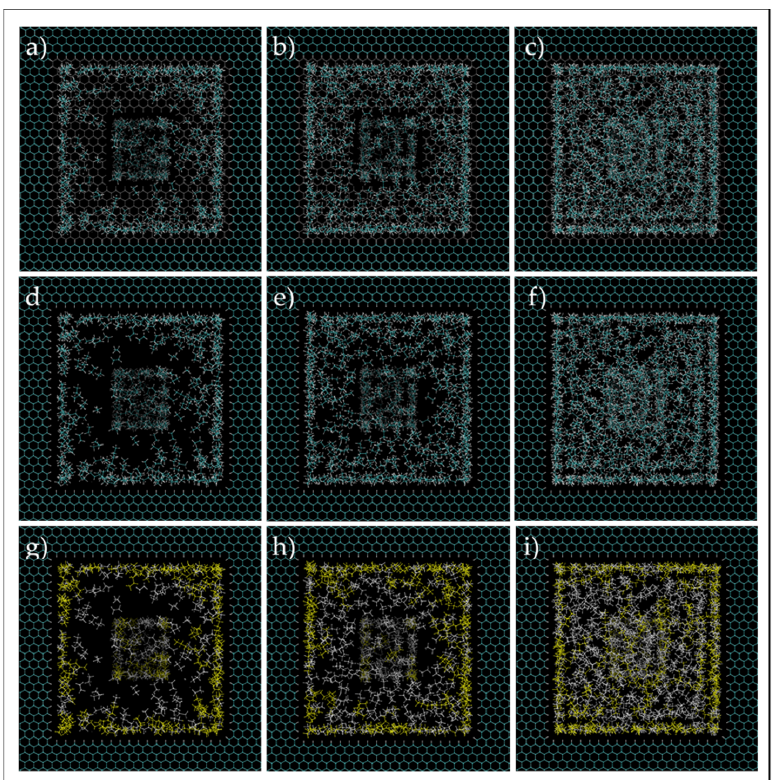
Figure 17. Ethane–heptane mixture simulation in two connected nanopores at C1 ( a , d , g ), C2 ( b , e , h ), C3 ( c , f , i ). Images ( d – f ) are the same as ( a – c ), but the 2-nm pore wall entrance is not shown in the former. Cyan and white spheres, for images at first and second rows, are carbon and hydrogen atoms, respectively. Yellow and white colors are heptane and ethane molecules, respectively, for images at the third row.